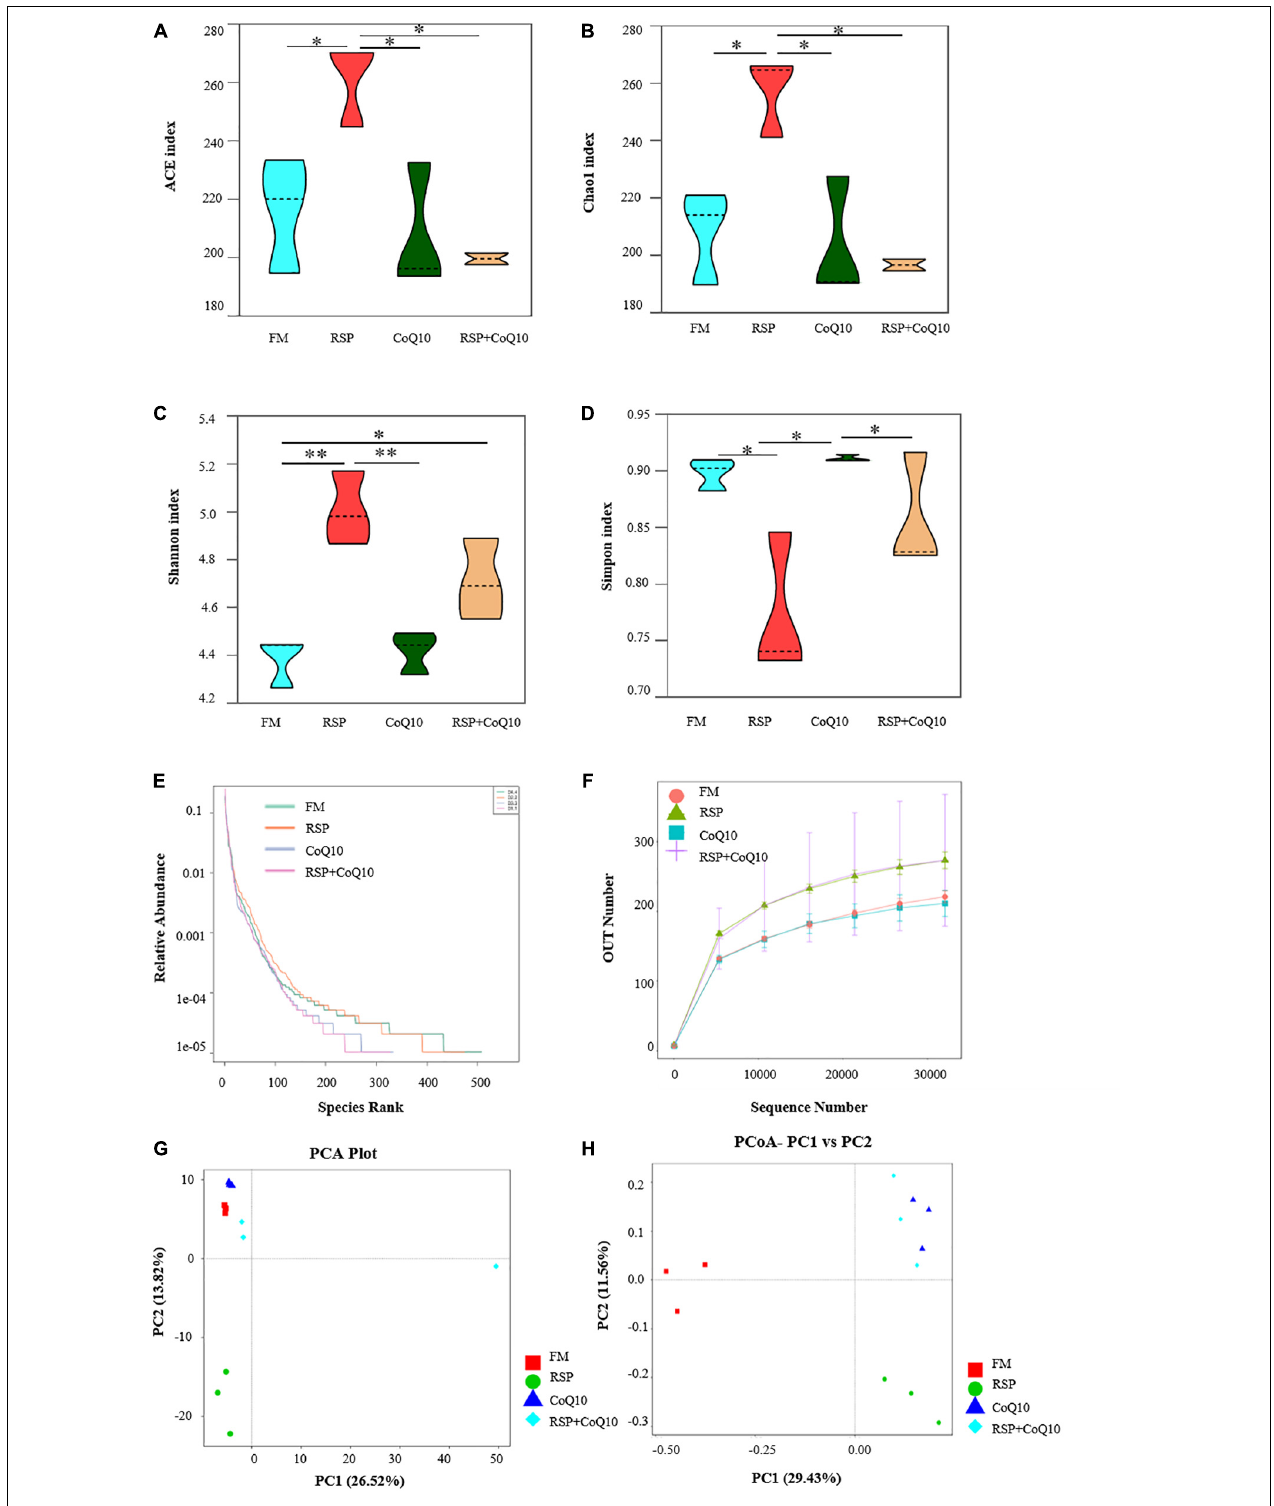
FIGURE 2 | Alpha diversity index statistics and beta diversity analysis of intestinal microbiota in L. vannamei fed four different diet treatments. (A–D) Were the Ace, Chao1, Shannon and Simpson index of OTU level separately. Statistical differences were determined using two-way ANOVA. * P < 0.05; ** P < 0.01. (E,F) Dilution curve and grade abundance curves based on OTU analysis of L. vannamei intestines. (G) Principal co-ordinates analysis (PCoA) distribution plot. (H) Principal component analysis (PCoA) normalized distribution plot. PC1, the first principle component; PC2, the second principle component.